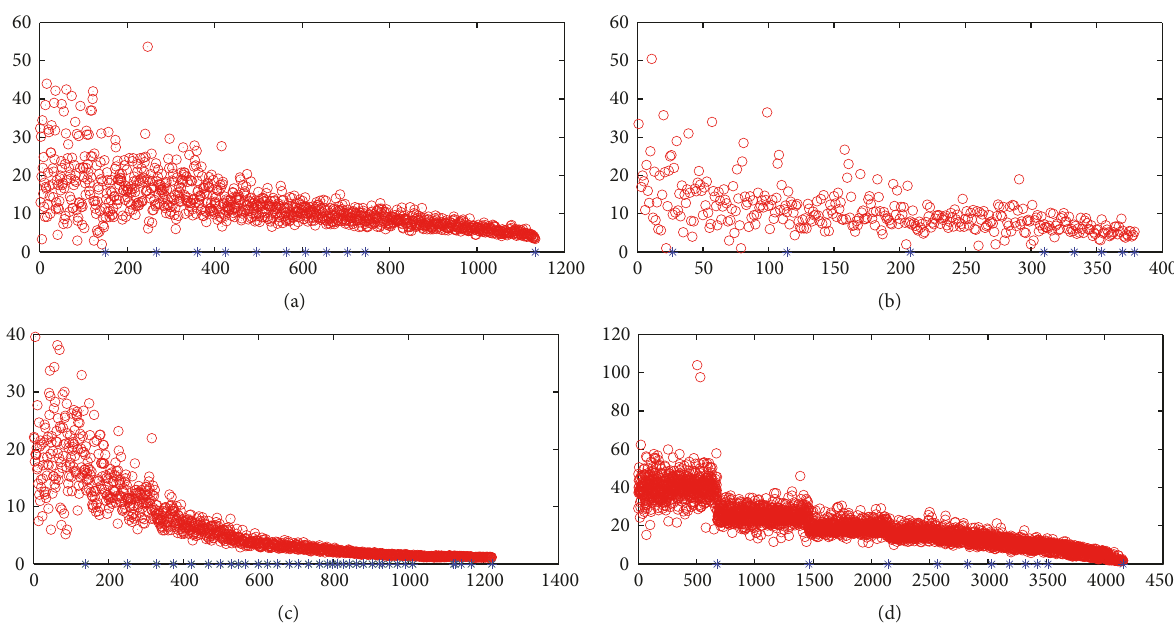
Figure 9: The propagation duration of each node in (a) Email-URV, (b) Netsci, (c) PolBlogs, and (d) Ca-GrQc, respectively. The high layer nodes have the effect of shortening the propagation process.